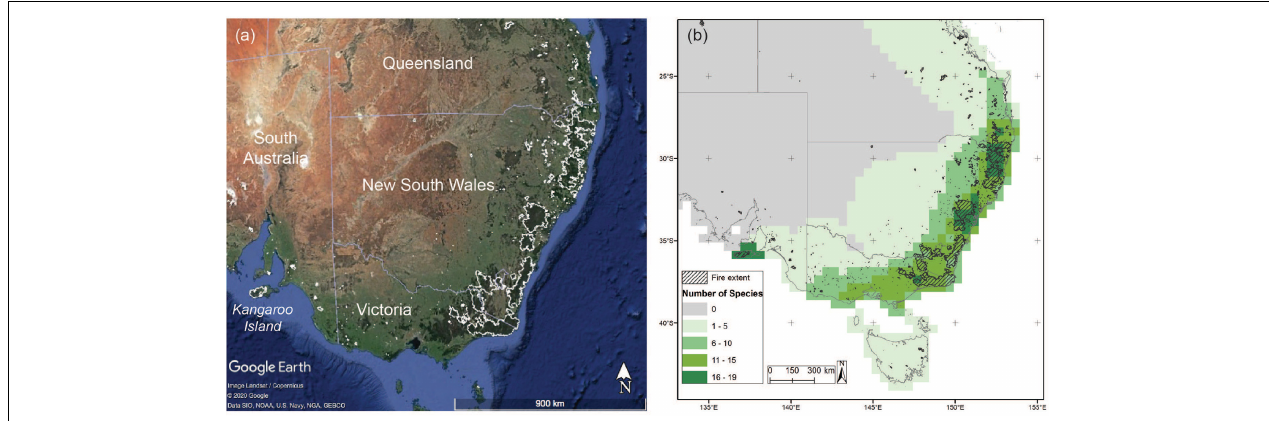
FIGURE 1 | The extent of the fires (a) is shown over a Google Earth satellite image. The fire extent (from the Commonwealth National Indicative Aggregated Fire Extent Dataset) is outlined in white, and dark green regions on the image represent pre-fire closed forests. Areas where conservation units could not be assigned across the 59 species assessed, due to a lack of genetic samples, are shown in panel (b) (from Catullo and Moritz, 2020). Colour indicates the number of species in a grid cell for which populations from that area could not be assigned to a conservation unit, with the fire extent shown in the